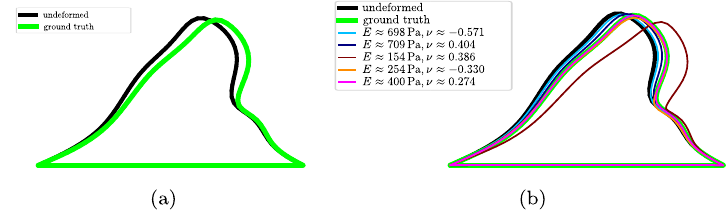
Fig. 4 Exemplary forward model results for deformed interface shapes for different input parameter samples compared to the result with ground truth x gt = [ ν = 0 . 3 , E = 400Pa] T as input and the undeformed state